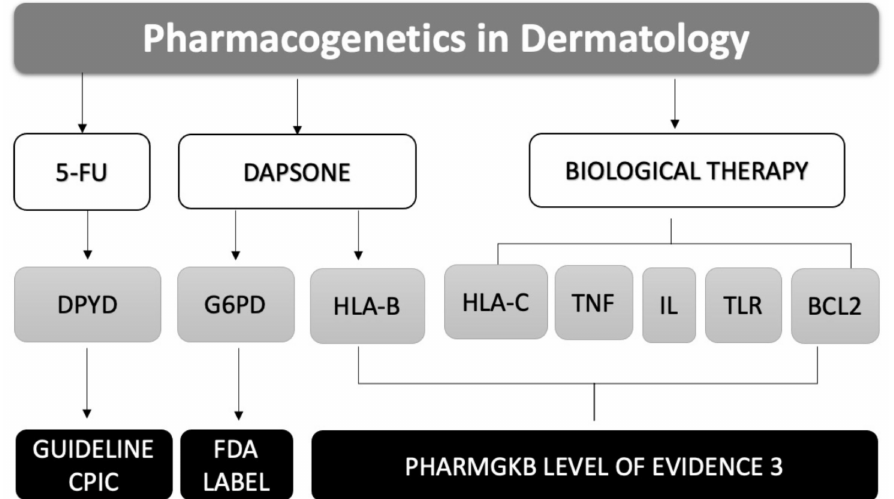
Figure 1. Graphical abstract of pharmacogenetics in clinical